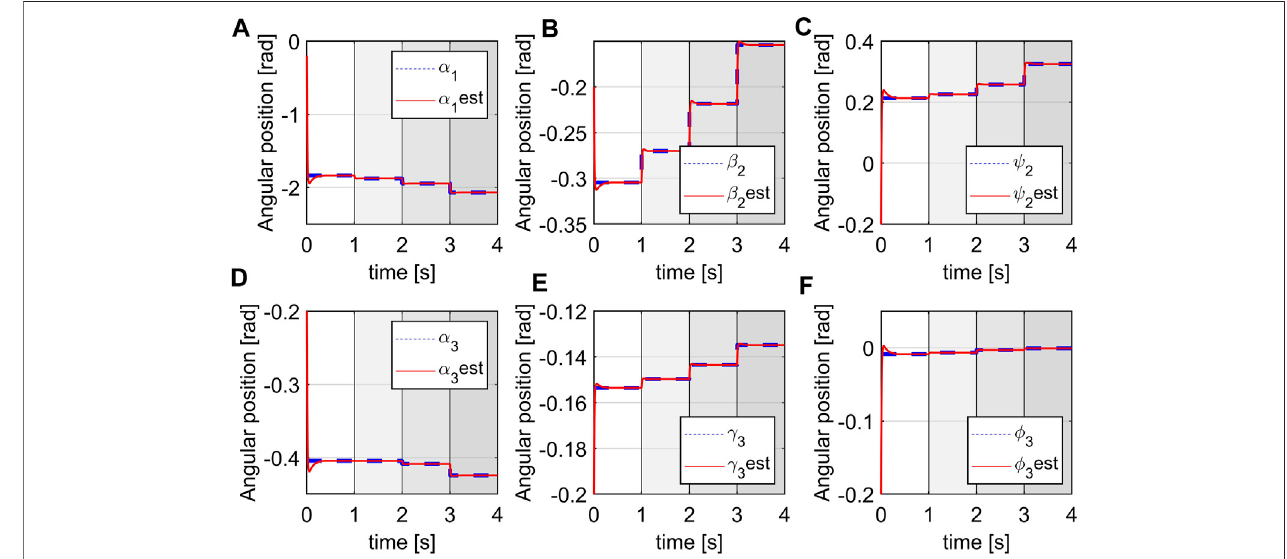
FIGURE 11 | Estimation of the rate of changes of space variables, (A) p 1 , (B) p 7 , (C) p 9 , (D) p 11 , (E) p 13 , (F) p 15 .